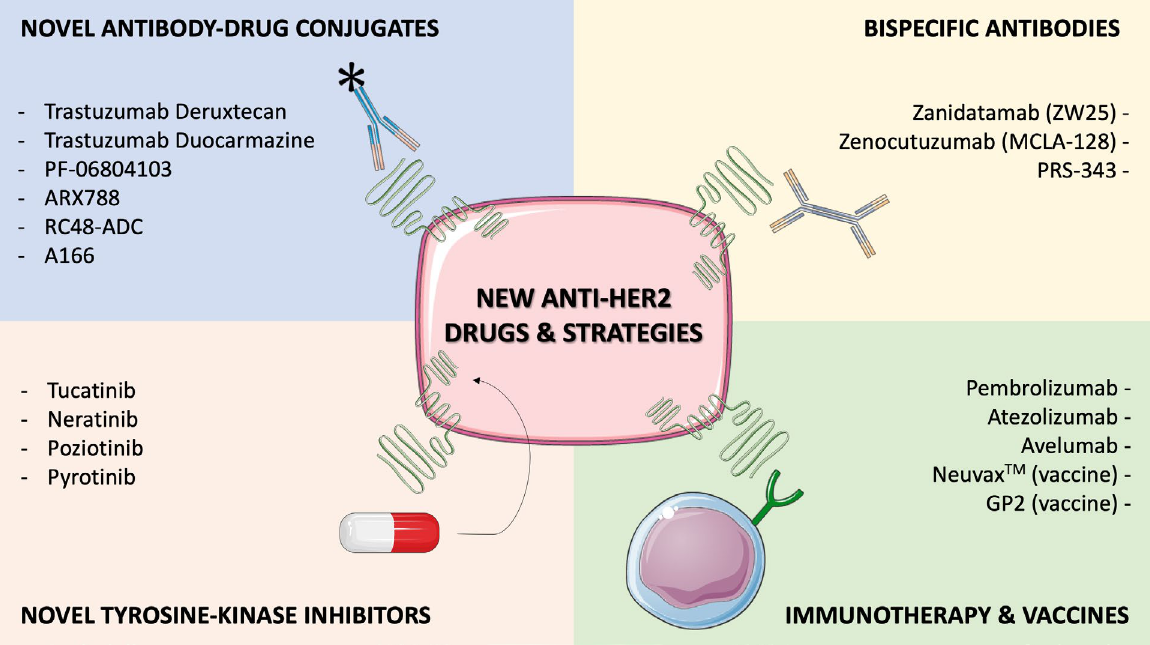
Figure 1. Selected, novel anti-HER2 agents or strategies under development, with available clinical data. Several drugs are currently emerging to improve outcomes in HER2 + BC patients, including novel ADCs, novel TKIs, bispecific antibodies (bsAbs) and immune-oncology agents. Early clinical data is available for all the compounds listed in this Figure, and for some of them confirmatory randomized trials are ongoing (e.g., trastuzumab deruxtecan, trastuzumab duocarmazine) or completed (e.g., tucatinib, neratinib). This figure was created using Servier Medical Art templates, which are licensed under a Creative Commons Attribution 3.0 Unported License;